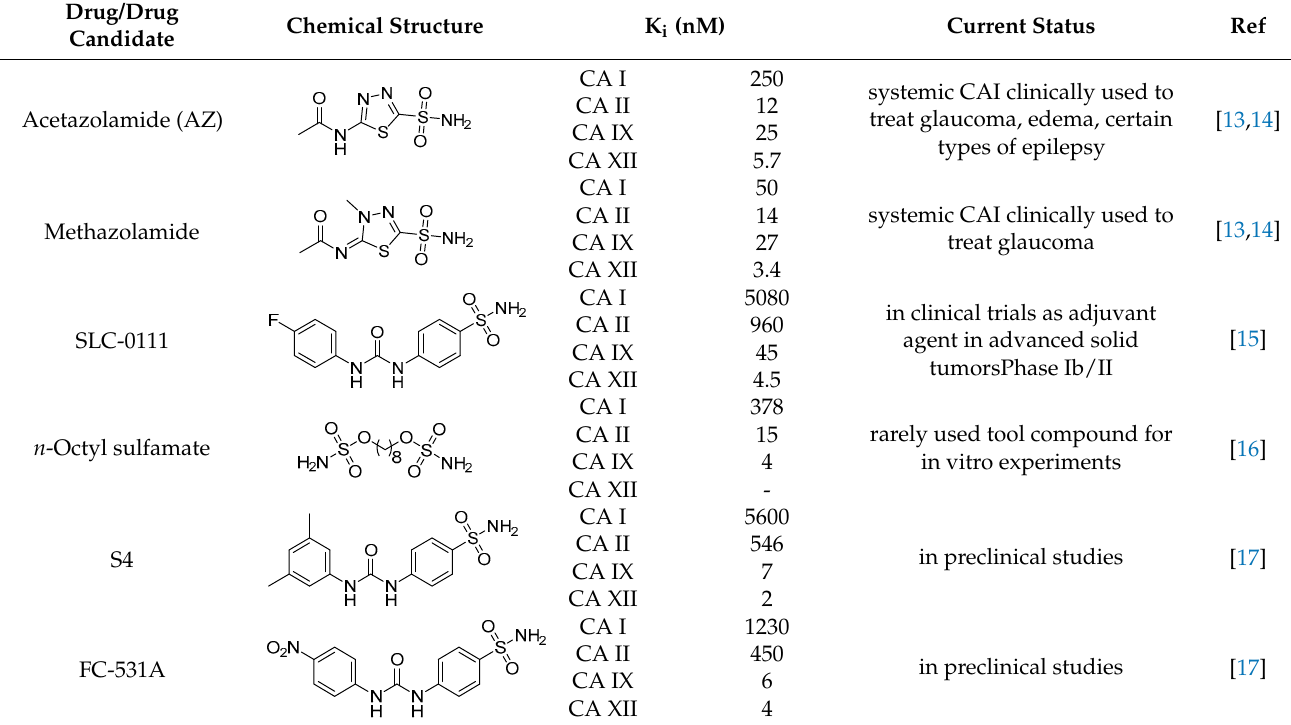
Table 1. CA inhibitory agents evaluated for combination cancer treatment, their Ki values against therapeutically relevant enzyme isoforms and general information on the current status.